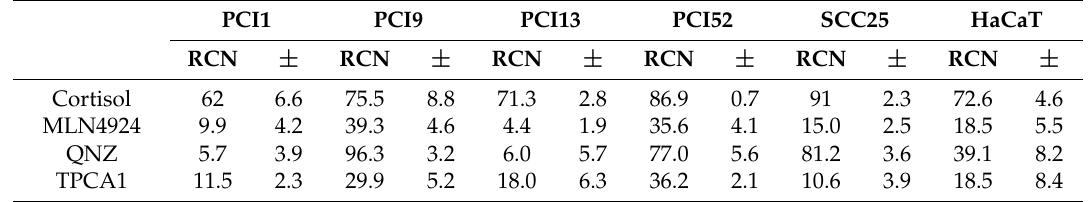
Table 2. Relative cell numbers (%) after 72 h of incubation with the highest concentrations of the NF κ B inhibitors. The table shows the RCN value after incubation for 72 h with Cortisol (50 µ g/mL), MLN4924 (100 µ M), QNZ (10 µ M) and TPCA1 (100 µ M). The values agree with the values shown in Figure 2 at the highest indicated concentration. The ± columns show the standard